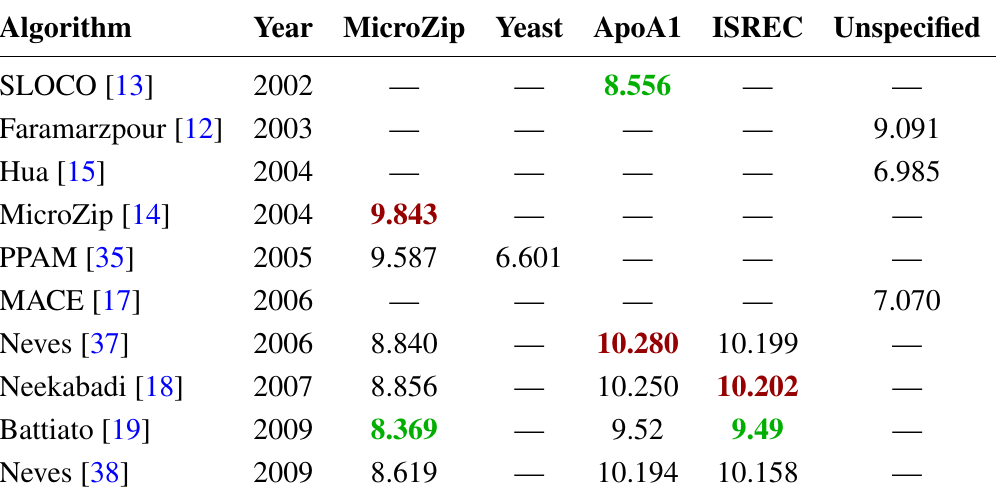
Table 3. Comparison of lossless microarray-specific schemes on 16 bpp images. All results are expressed in bits per pixel (bpp), so lower is better. All results have been adopted directly from the references specified in the table. Best results for each specified image set have been highlighted in green , and worst results in red